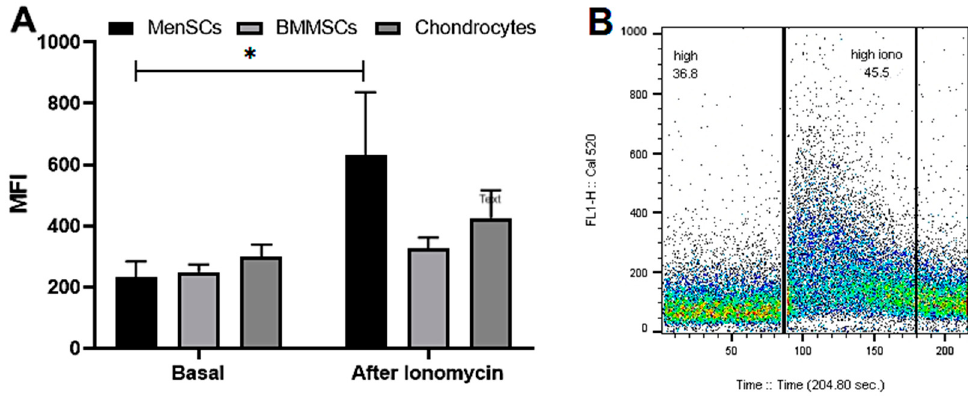
Figure 3. The ionomycin-induced iCa 2+ release in MenSCs, BMMSCs and chondrocytes. Cells were stained with Cal-520 and analyzed with flow cytometer (Calibur). ( A ) The iCa 2+ fluorescence is shown as mean fluorescence intensity (MFI) ± standard deviation (SD) before and 90 s after adding the ionomycin (1 µM). * Data are shown as mean ± standard deviation (SD) and are considered significant at p ≤ 0.05 ( n = 5). ( B ) The representative cell population measurement before and after adding the ionomycin (1 µ M at 90 s). The two-way ANOVA was used to compare